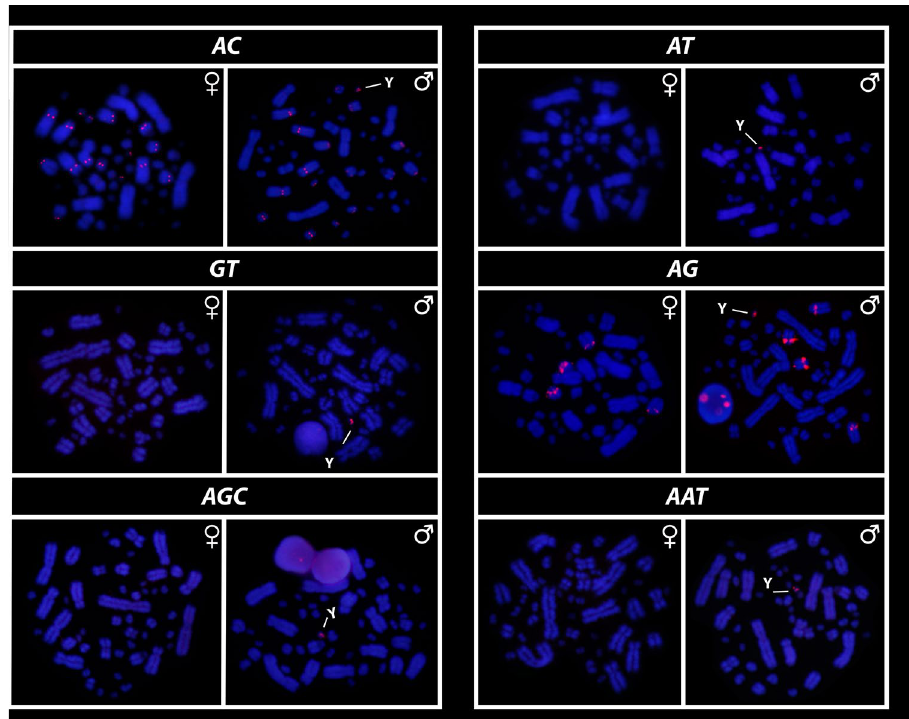
Figure 2. Mapping of several SSR repeats on the chromosomes of male and female of Chelus fimbriata , with highlights to an association of AG motif with the 9th pair that harbors the rDNA sites and the particular accumulation on the mic Y